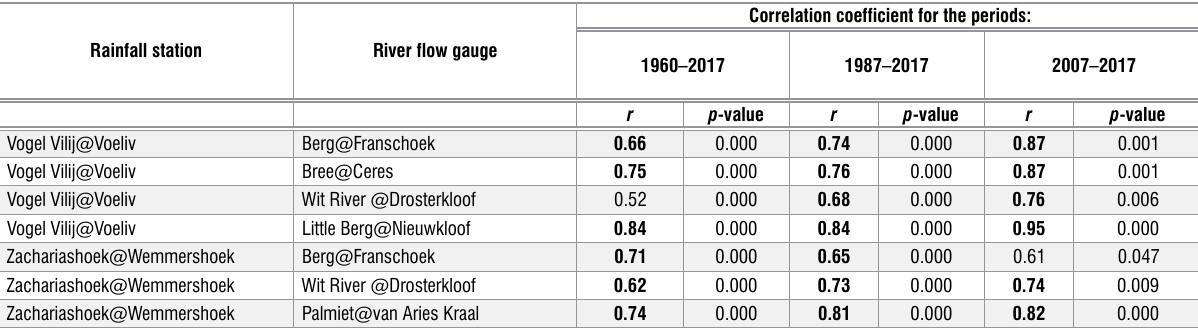
Rainfall station